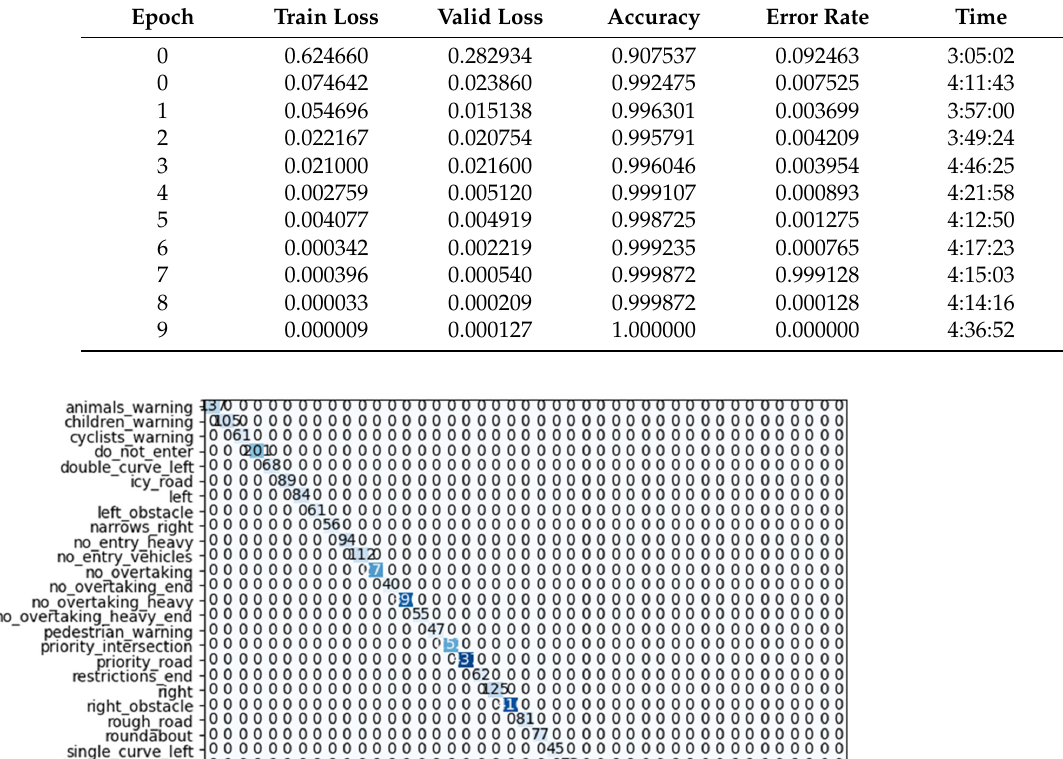
Table 7. Results of the SqueezeNet1-1.